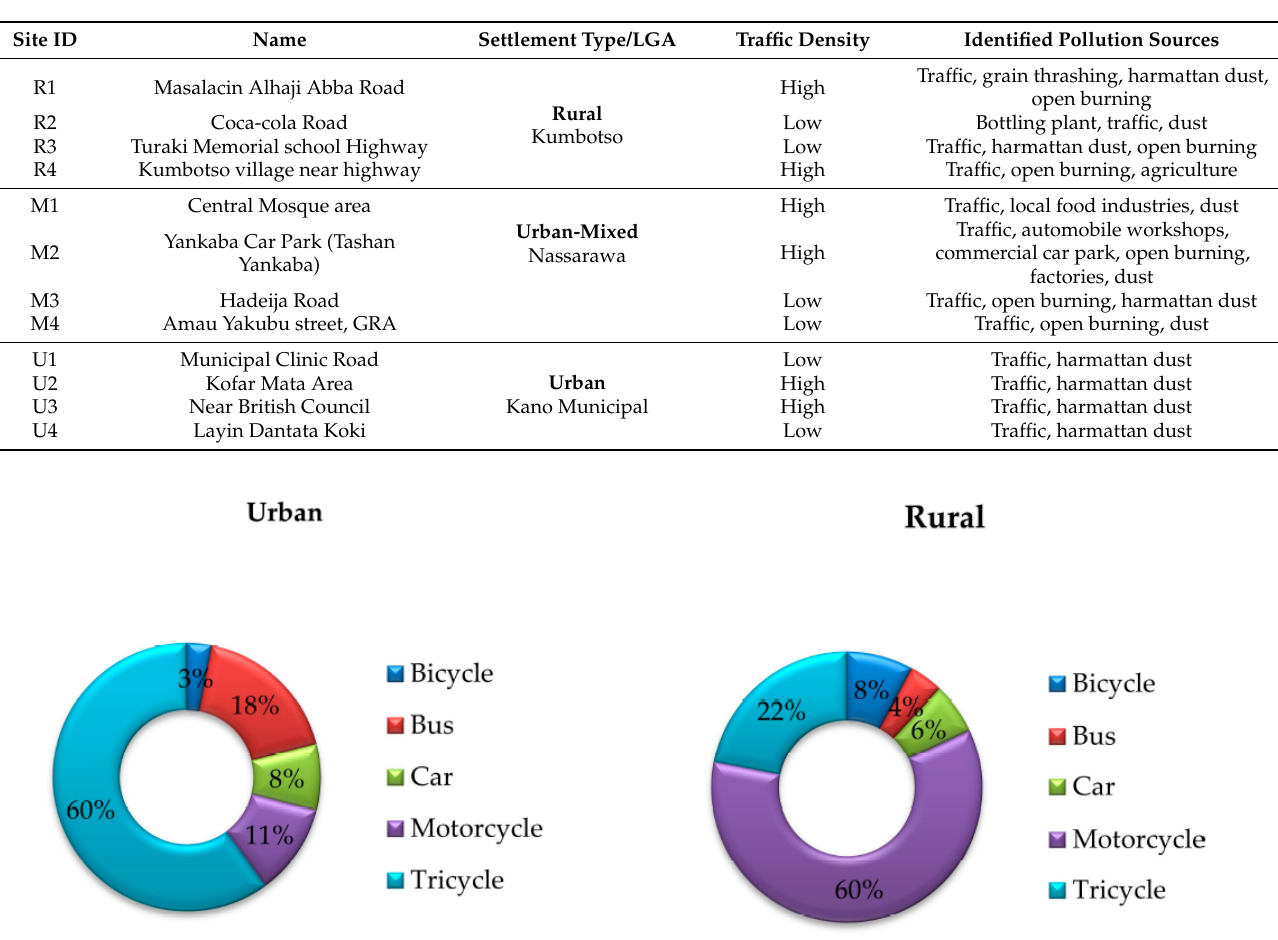
Figure 2. Distribution of Road Transportation Vehicles in Kano State’s rural and urban settlements [57].